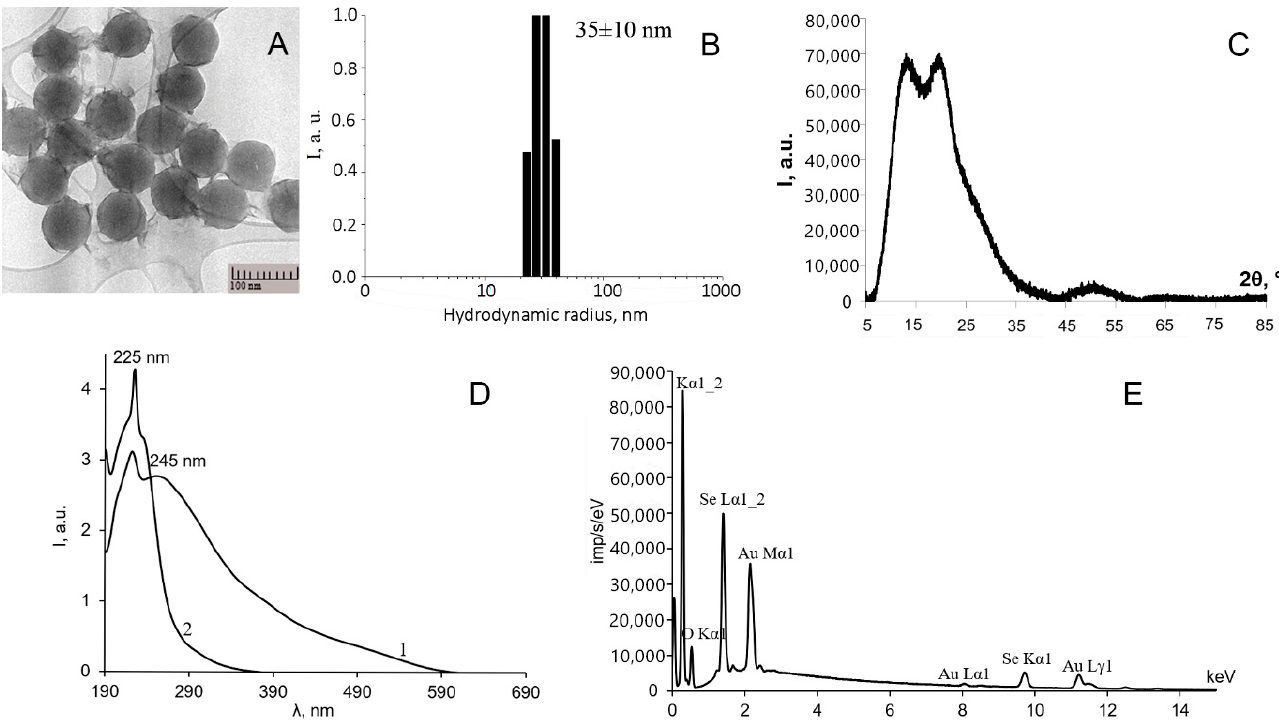
Figure 2. Elemental composition and structure of preparation of selenium nanoparticles stabilized with PVP C15 (8 ± 2 kDa) and ascorbic acid: ( A ) TEM micrograph; ( B ) histogram of distribution of hydrodynamic radius; ( C ) diffractogram; ( D ) absorption spectra of a selenium sol sample (1) and an aqueous solution of polyvinylpyrrolidone (2); ( E ) EDX spectra of the dried nanoselenium sol sample.